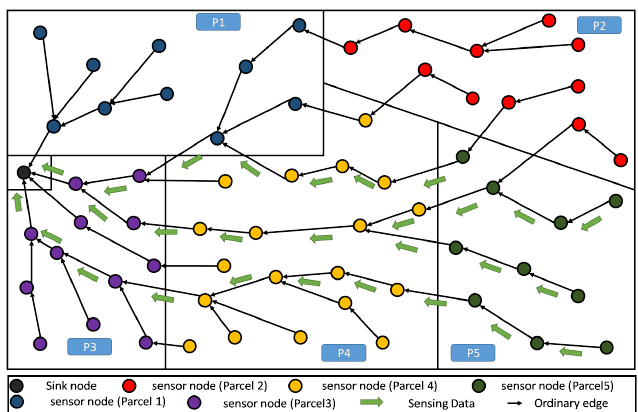
Figure 9. Standard RPL DODAG: difficult to support aggregation at parcel level.